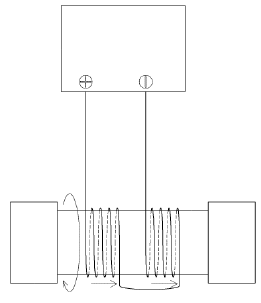
Figure 5. Phase-matching connection of neighboring solenoids by reversed series